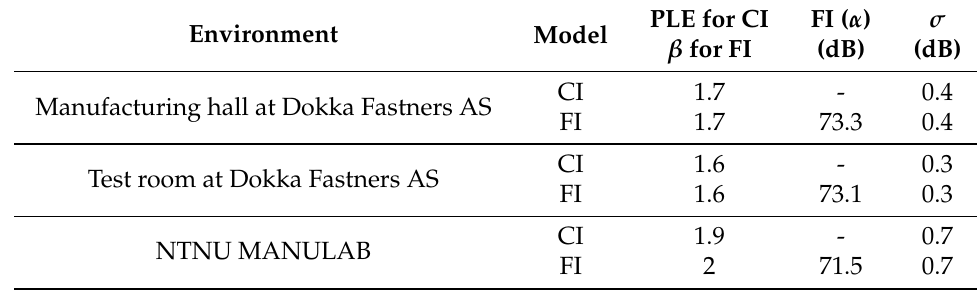
Figure 8. Path loss models in ( a ) the Manufacturing hall at Dokka Fastners AS, ( b ) the Test room at Dokka Fastners AS, and ( c ) NTNU MANULAB. FSPL, free space path loss; CI, close-in free space reference distance; FI, floating intercept. Table 4. Path loss models’ parameters. PLE, path loss